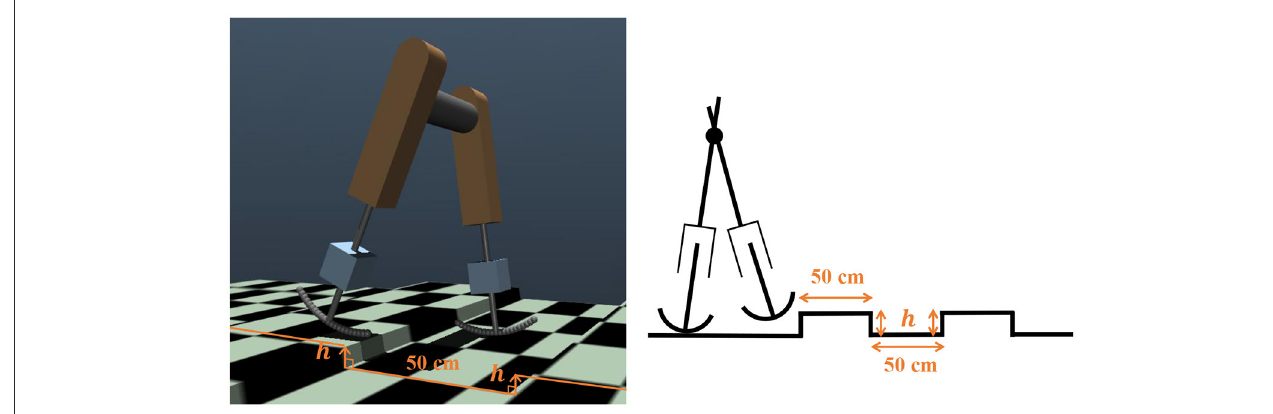
FIGURE9 Environmental changes introduced using steps in a simulation environment and its diagram.